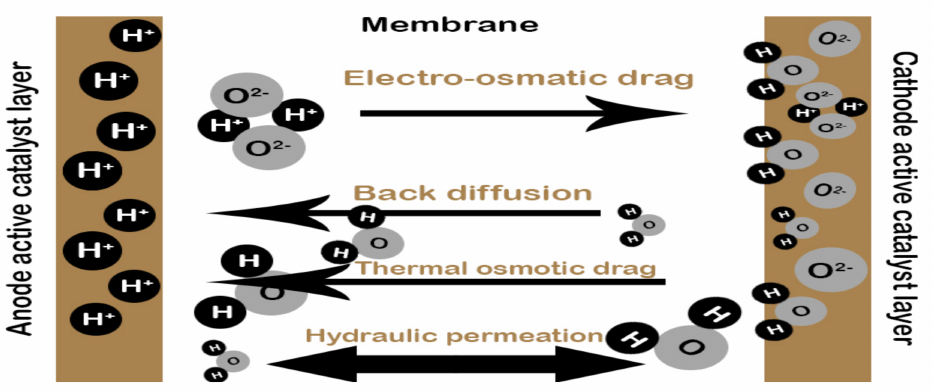
Figure 2. Water transport mechanism in a PEM fuel